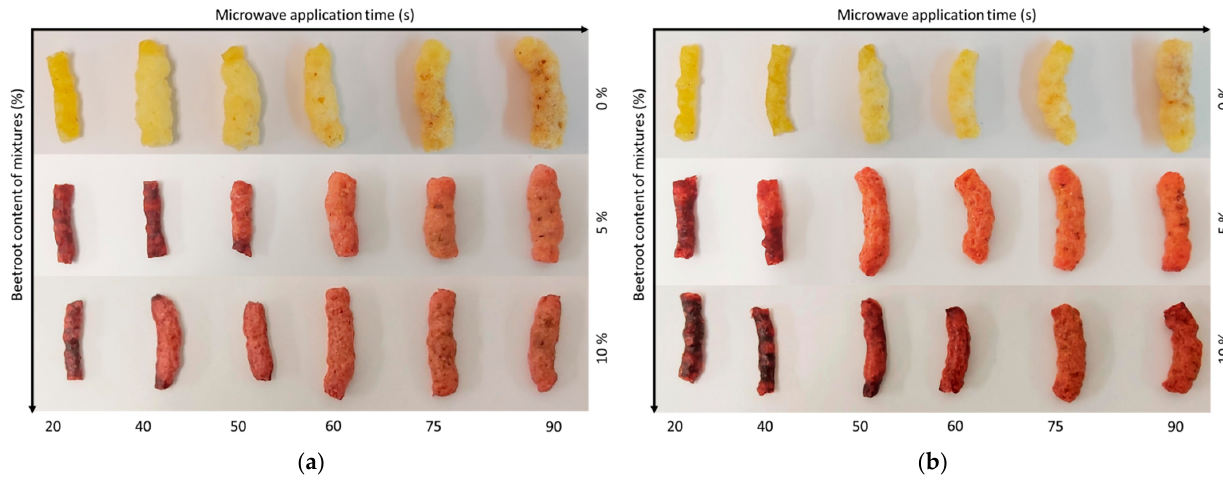
Figure 4. ( a ) Evolution of the appearance of snack with 25% of water content as a function of the processing time for the beetroot content of its mixtures. ( b ) Evolution of the appearance of snack with 30% of water content as a function of the processing time for beetroot content of its mixtures. According to a microwave expansion kinetics study, the best time was obtained